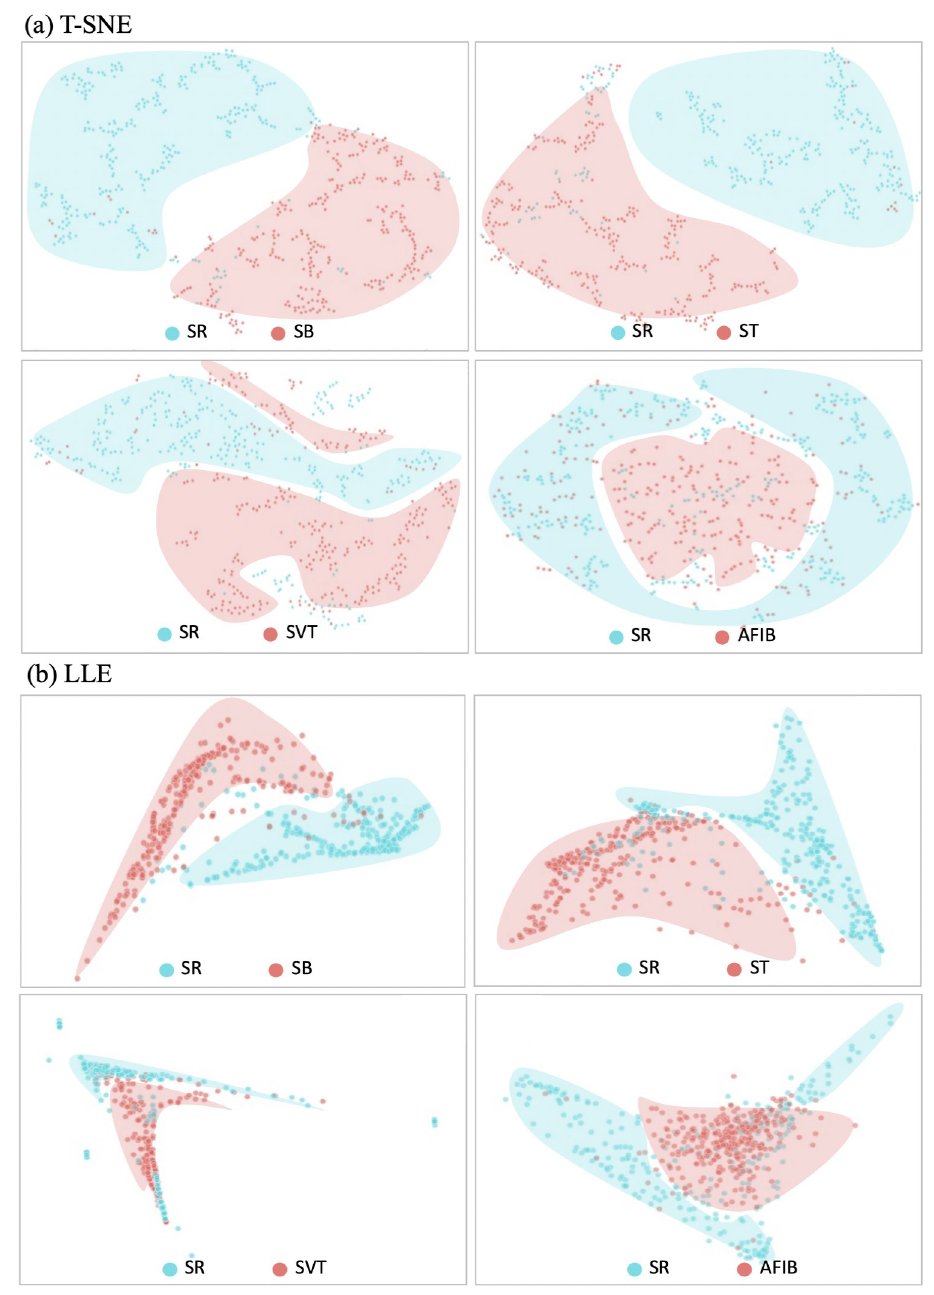
Fig 2. Visualization of (a) t-Stochastic Neighbor Embedding (t-SNE) and (b) Locally Linear Embedding (LLE) in two- dimensional space for normal sinus rhythms and arrhythmias. Normal sinus rhythms are shown as blue clusters while arrhythmias are shown as red clusters. It shows that feature vectors can represent the differences between normal and arrhythmic rhythms although the model was trained without any label. Abbreviations: SR: normal sinus rhythm; ST: sinus tachycardia; SVT: supraventricular tachycardia; AFIB: atrial fibrillation.